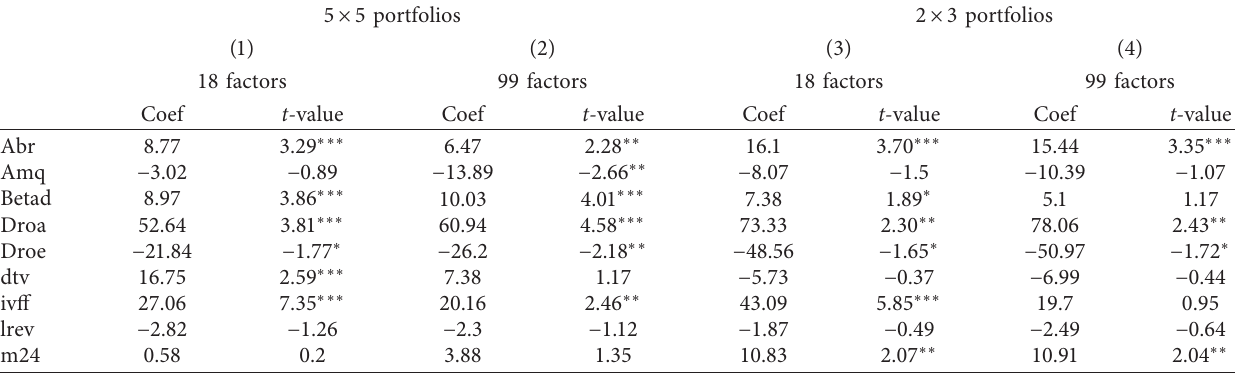
Table 10: Robustness for testing SDF loadings of g t . This table reports robustness results of SDF loading estimates using double-selection LASSO approach. The sample period is from July 2000 to December 2019. In columns 1 and 2, we use previous 650 5 × 5 bivariate sorted portfolios as test assets, while, in columns 3 and 4, we use 156 2 × 3 bivariate sorted portfolios. Columns 1 and 3 select controls from factors appearing in Table 3 as well as the liquidity factor AMI and Quality-Minus-Junk (QMJ) factor, while columns 2 and 4 select controls from an expanding set including totally 99 benchmark